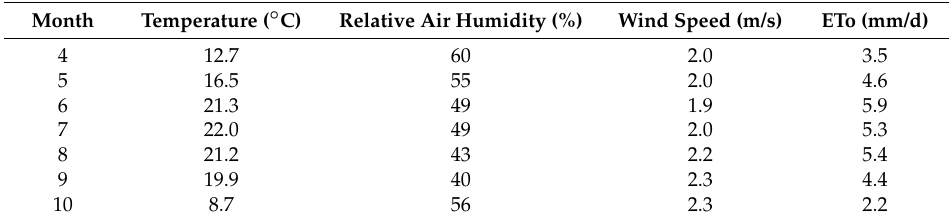
Table 3. Climate data and ETo in Karasy Batyr, monthly averages during the growing season 2016.